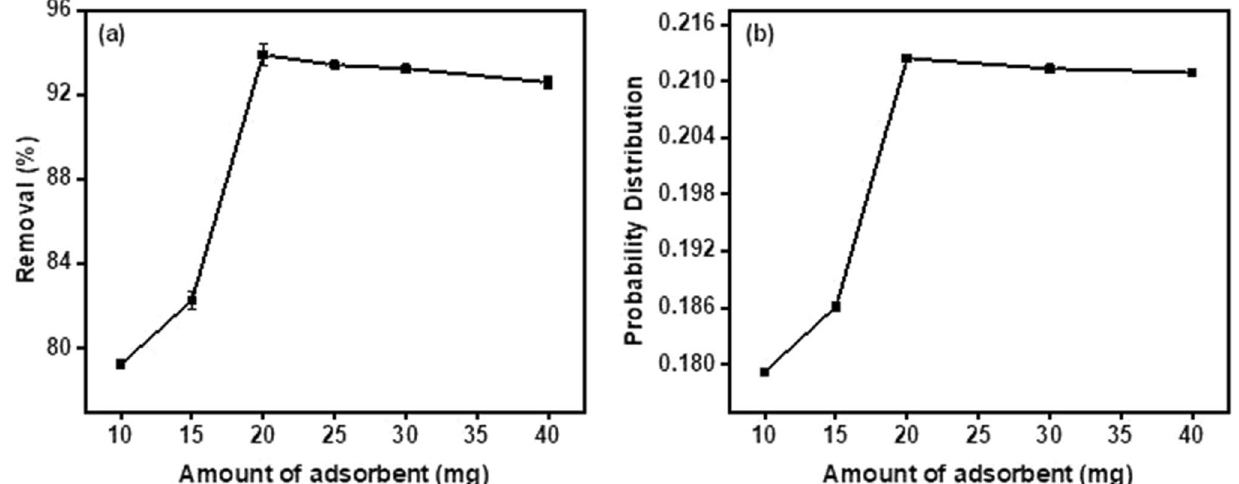
Fig. 9 Effect of His-MMt dosage on the percentage removal of As